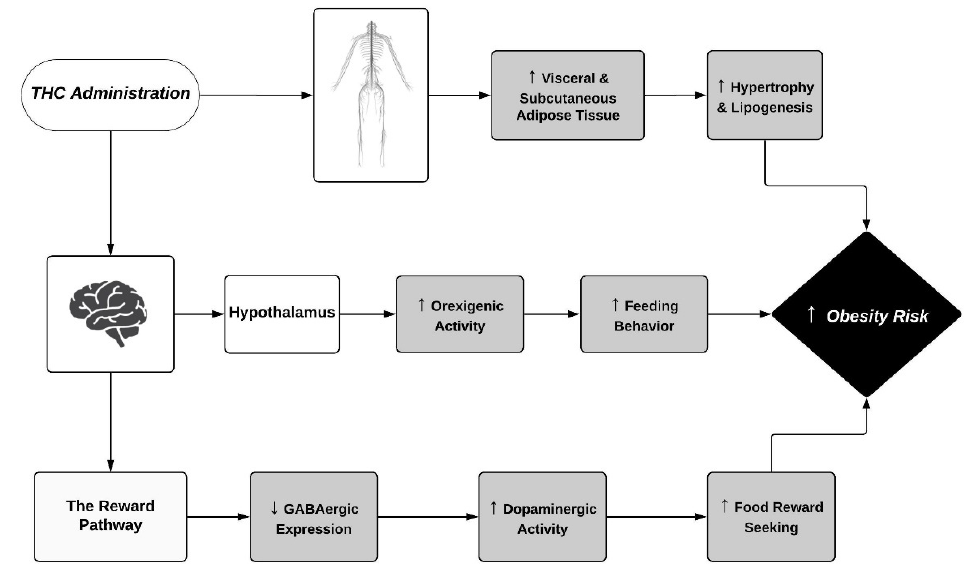
Figure 1. This mechanisms by which THC administration affects the physiological responses to obesity risks through both the central and peripheral nervous systems. The Central nervous system processes include the orexigenic pathway through the hypothalamus and the reward pathway through the nucleus accumbens and ventral tegmental area. Peripheral nervous system processes largely include the retention of visceral and subcutaneous adipose tissue. Symbols ↑ and ↓ denote an observed increase and decrease, respectively.